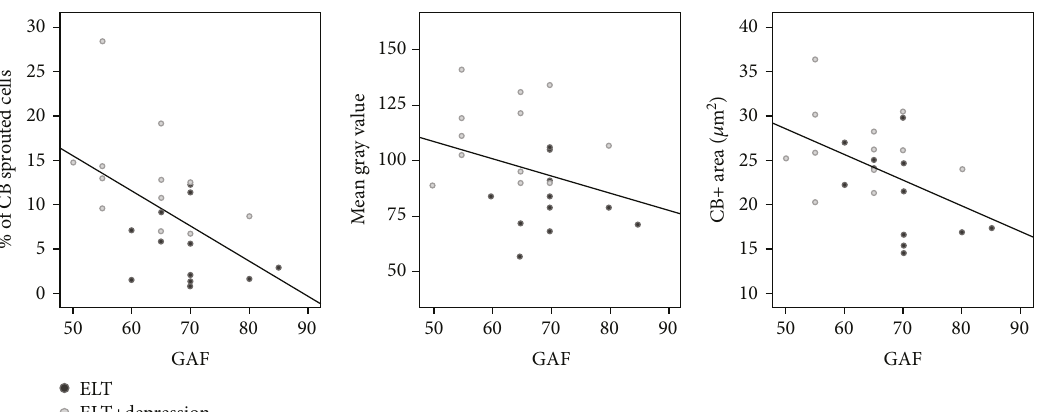
Figure 5: The GAF (global assessment of functioning, DSM-IV) inversely correlated with the % of CB sprouted cells ( r = − 0 52 , p = 0 008 ), with the CB+ area ( r = − 0 46 , p = 0 022 ), and with the optical density (mean gray value) ( r = − 0 33 , p = 0 14